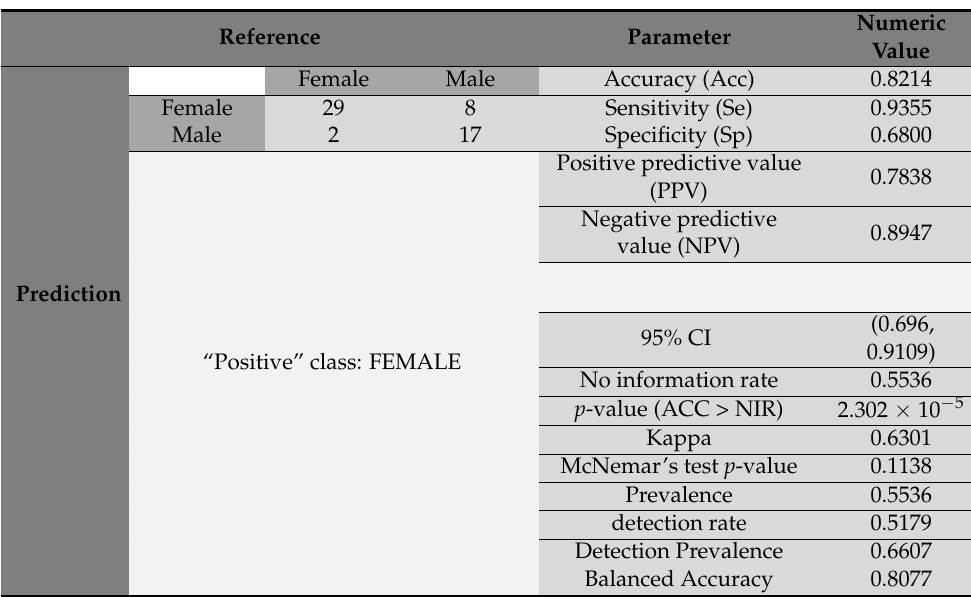
Table 1. Confusion matrix of the test sample.